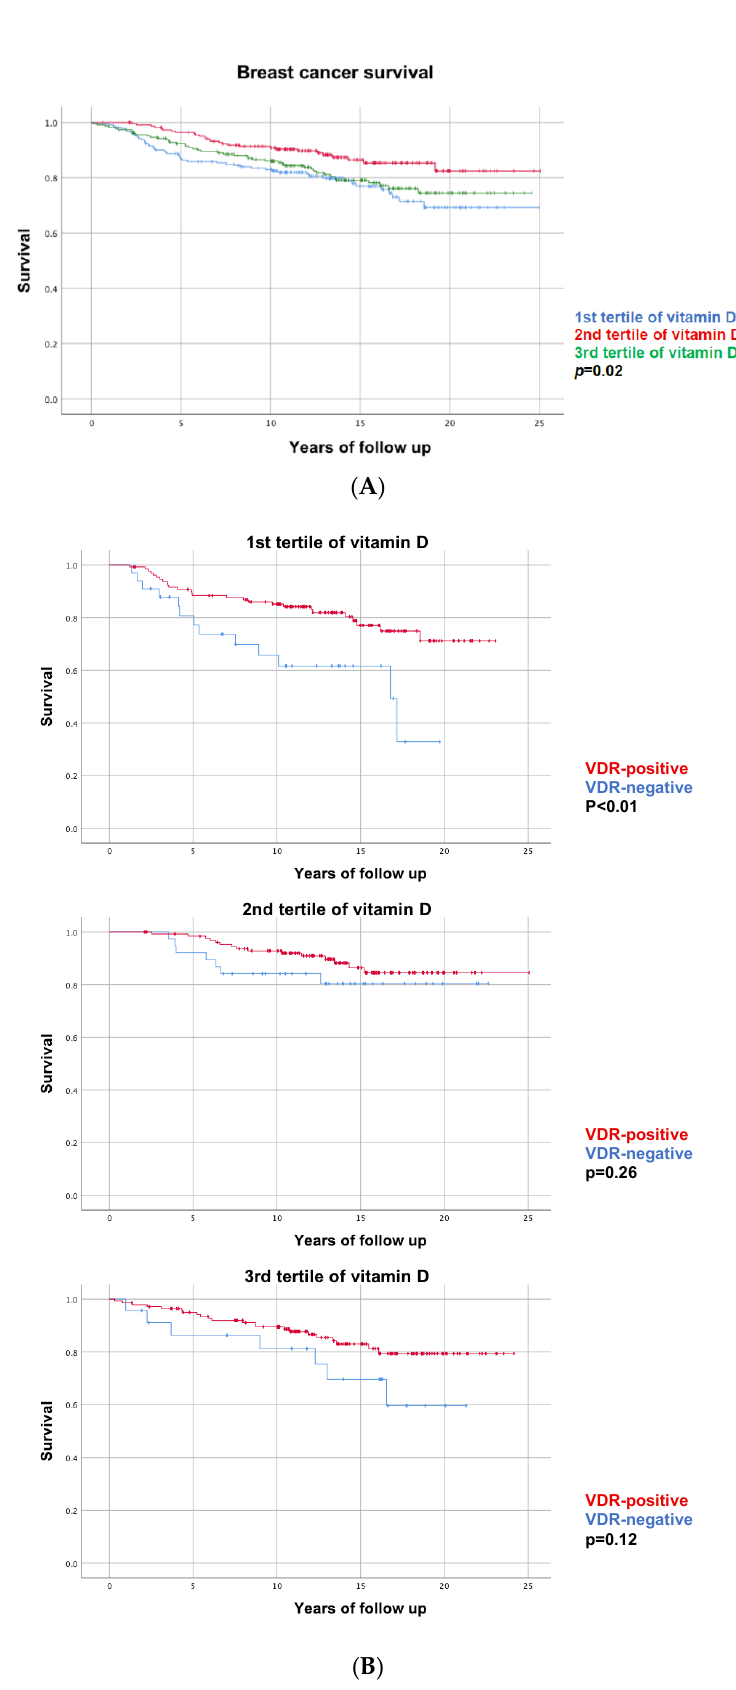
Figure 2. ( A ) Kaplan-Meier curve showing breast cancer survival by tertiles of vitamin D. ( B ) Kaplan- Meier curves showing breast cancer survival by VDR expression stratified by tertiles of vitamin